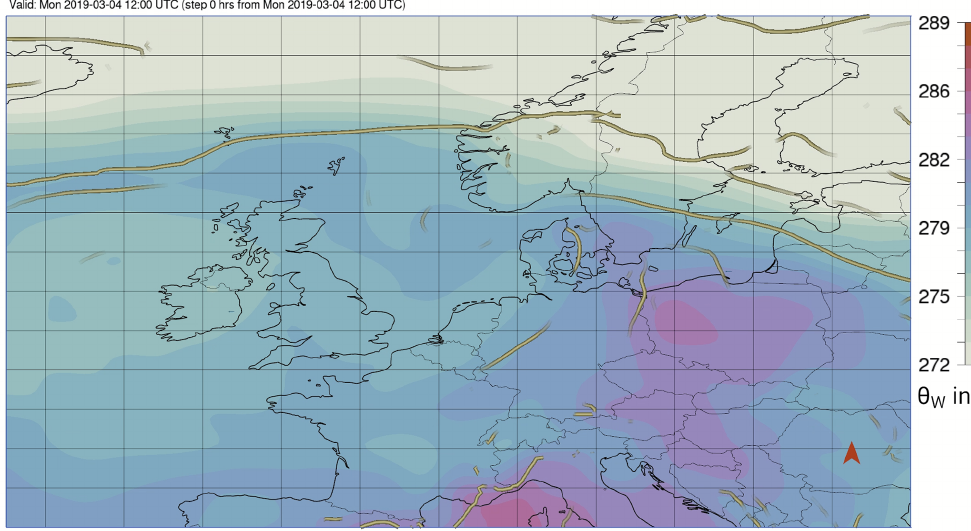
Figure D5. As in Fig. D4 but for storm Bennet on 4 March 2019 at 12:00UTC.